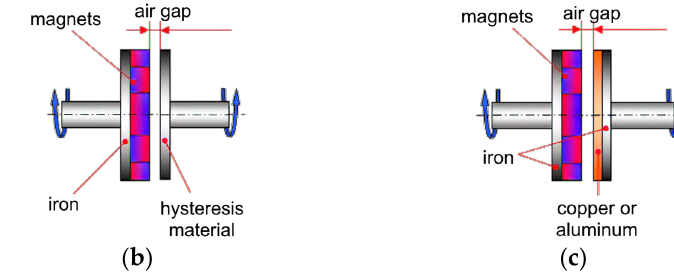
Figure 2. Type of MCs: ( a ) Active/Reactive coupler; ( b ) Hysteresis coupler; ( c ) Eddy-current cou- pler.